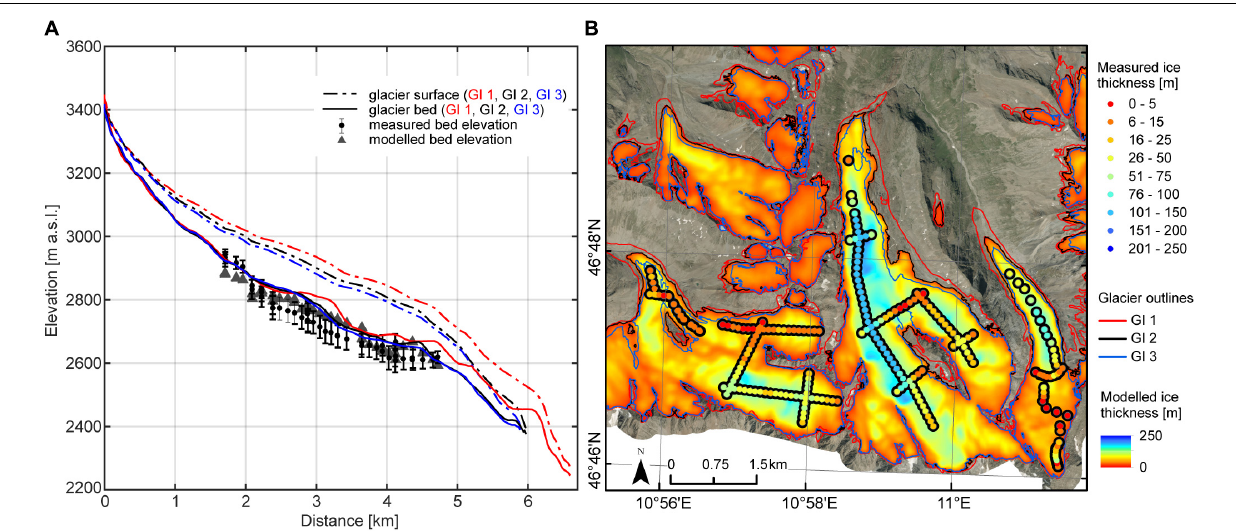
FIGURE 2 | (A) Mean glacier surface elevation from 10 m – elevation bands for the respective glacier inventories GI 1 (red), GI 2 (black), and GI 3 (blue), and the glacier bed modeled using the HF model are shown with the measured and modeled bed elevation for locations of ice thickness measurements at Gurgler Ferner. The stems show the uncertainty of the ice thickness measurements. Measured and modelled ice thickness are presented in (B) highlighting the available data basis glacier outlines, the locations of ice thickness measurements and the modeled ice thickness distribution.